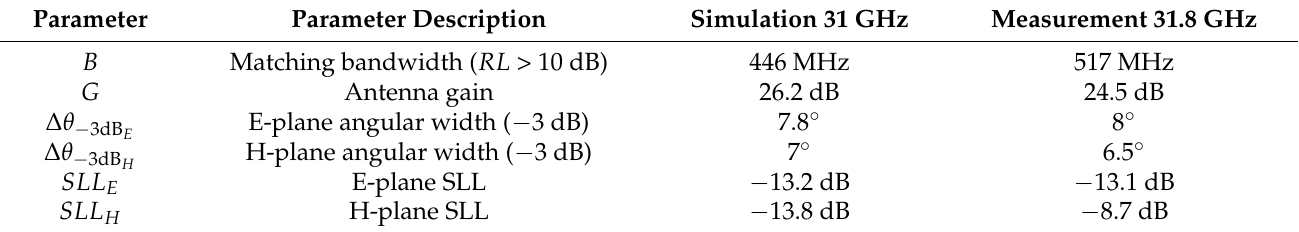
Table 3. Comparison between simulation and measurement results.